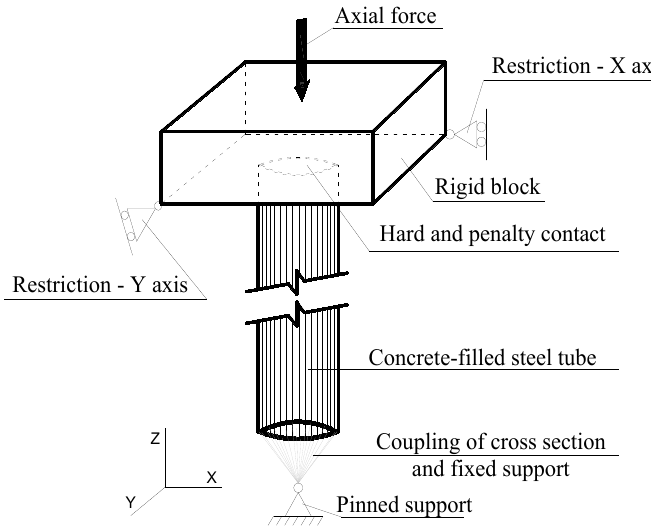
Figure 15. Boundary conditions and interactions imposed in the model.